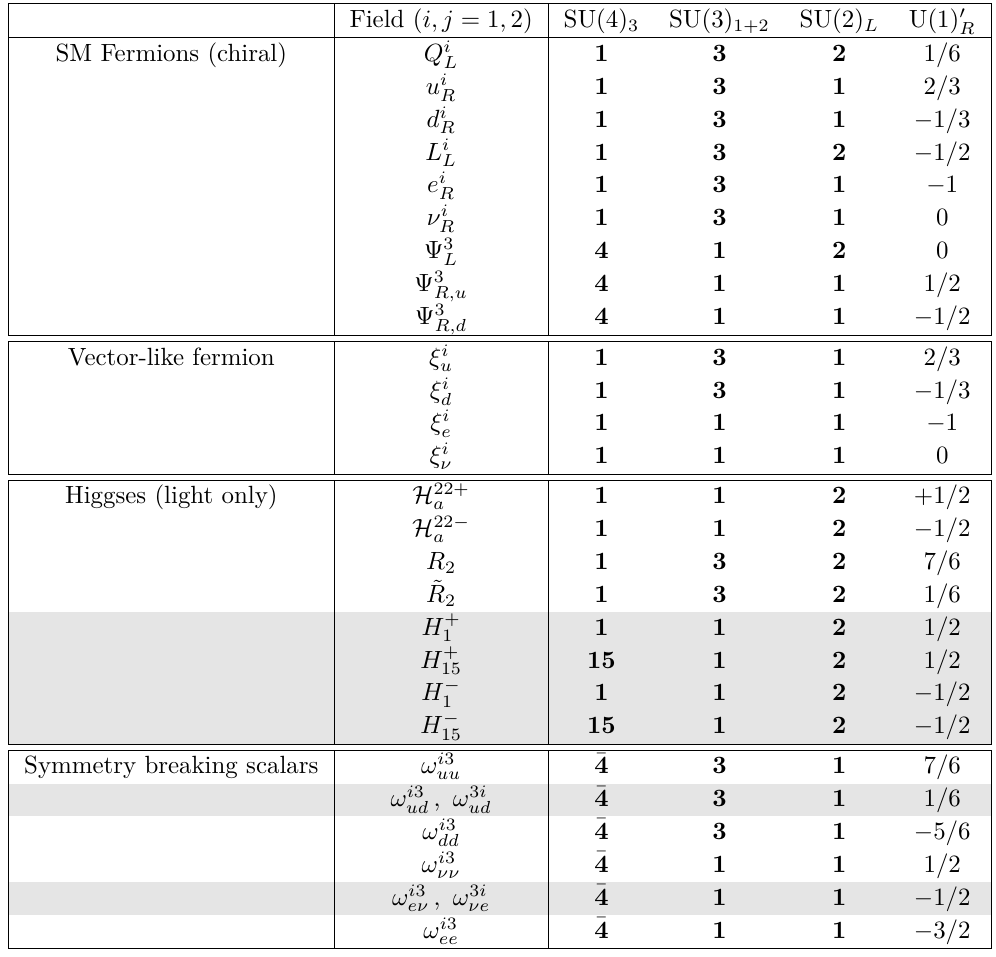
Table 2 . Field content of the model before 4321 breaking. Of the scalar fields (listed in the last two blocks), those that acquire non-vanishing vevs are indicated by grey